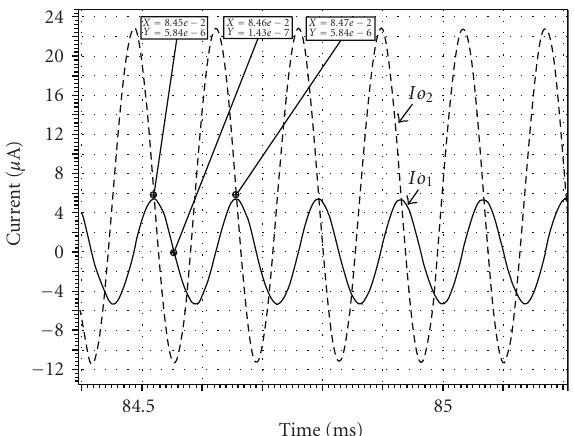
Figure 5: The simulated current-mode quadrature output wave- forms of Figure 3.